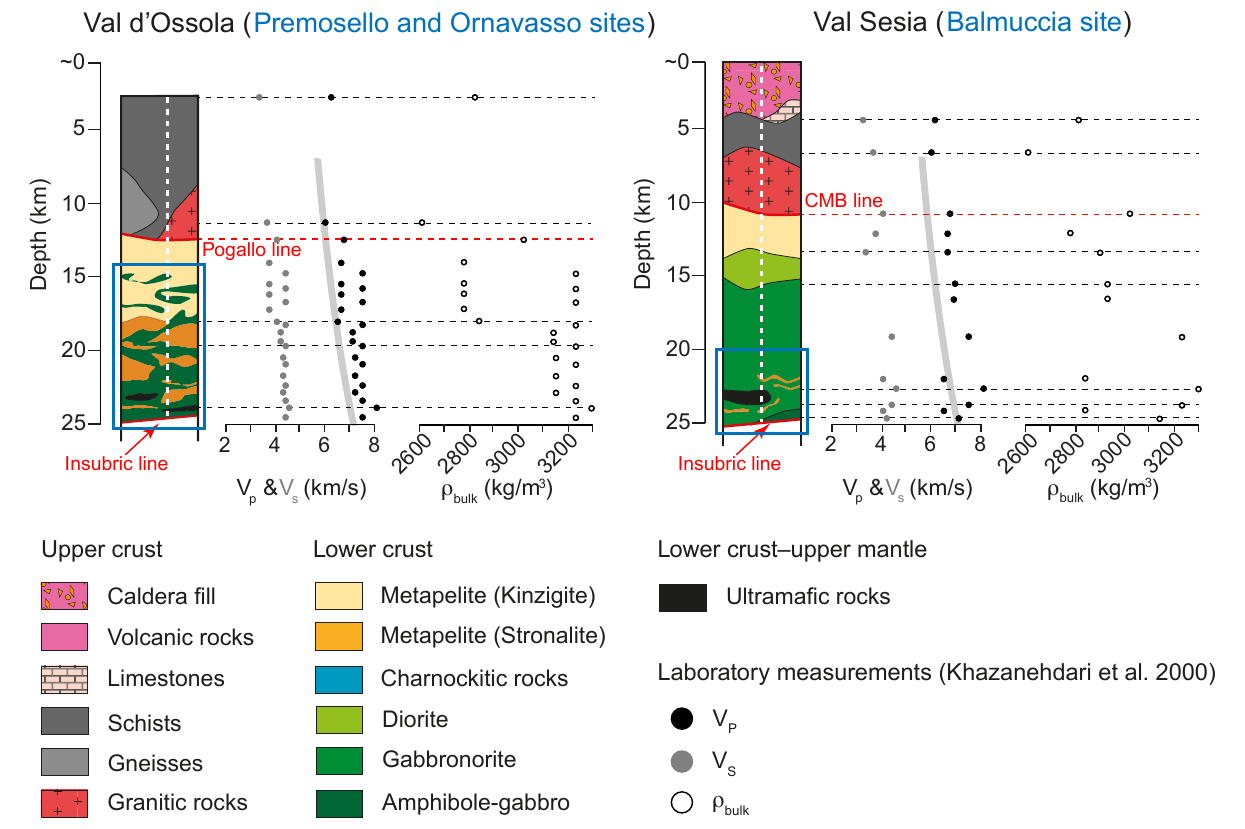
Figure 4. Schematic lithological, seismic, and density properties of bulk rocks from the main geological locations of the IVZ where the ICDP DIVE project will be targeted. Lithological data are from James (2001), Quick et al. (2003), Sinigoi et al. (2011), and Klötzli et al. (2014). Average bulk rock seismic P-wave and S-wave velocity ( V P and V S ) and density ( ρ bulk ) data are from Khazanehdari et al. (2000). The white dashed line indicates the pathway of plotted bulk rock seismic velocity and density data for each different lithology along the cross section. Grey band shows global average V P -depth relation for extended terrains (Christensen and Mooney, 1995). Blue squares highlight the lithologies at the drilling sites displayed in Fig.